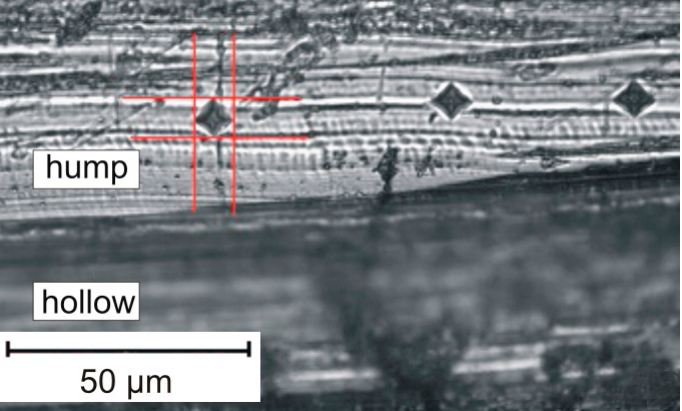
Figure 6. The technique for measuring the microhardness of a worn surface.